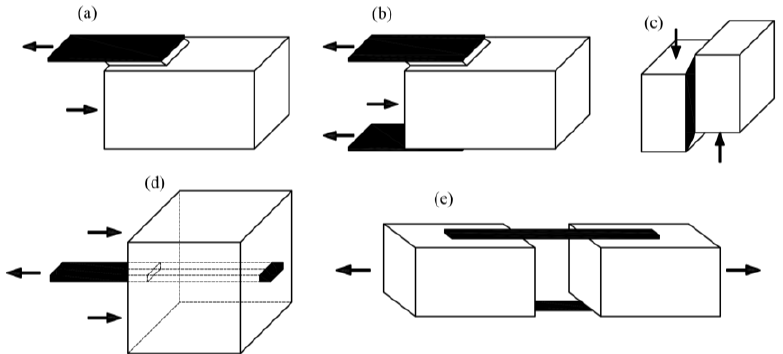
Figure 3. Methods of strengthening solid wood with fibre-reinforced polymer (FRP) outside—( a ) single-lap joint test, ( b ) double-lap joint test, ( c ) block shear test, ( d ) pull-out test, ( e ) four-lap joint test.